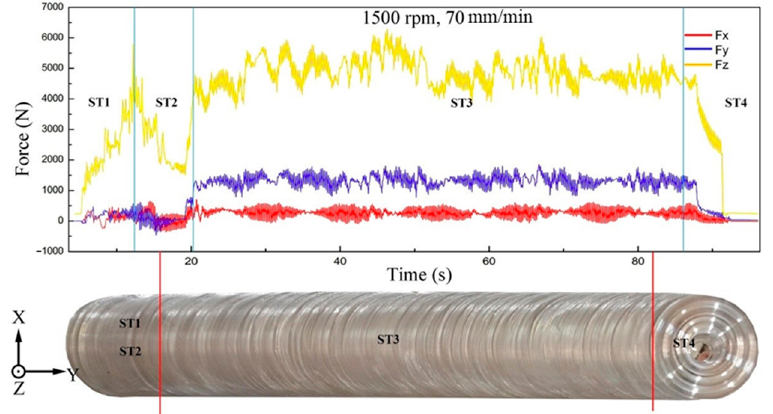
Figure 3. Schematic diagram of the time curves of the three forces on the spindle and the locations of the different phases under the condition of 1500 rpm and 70 mm/min.